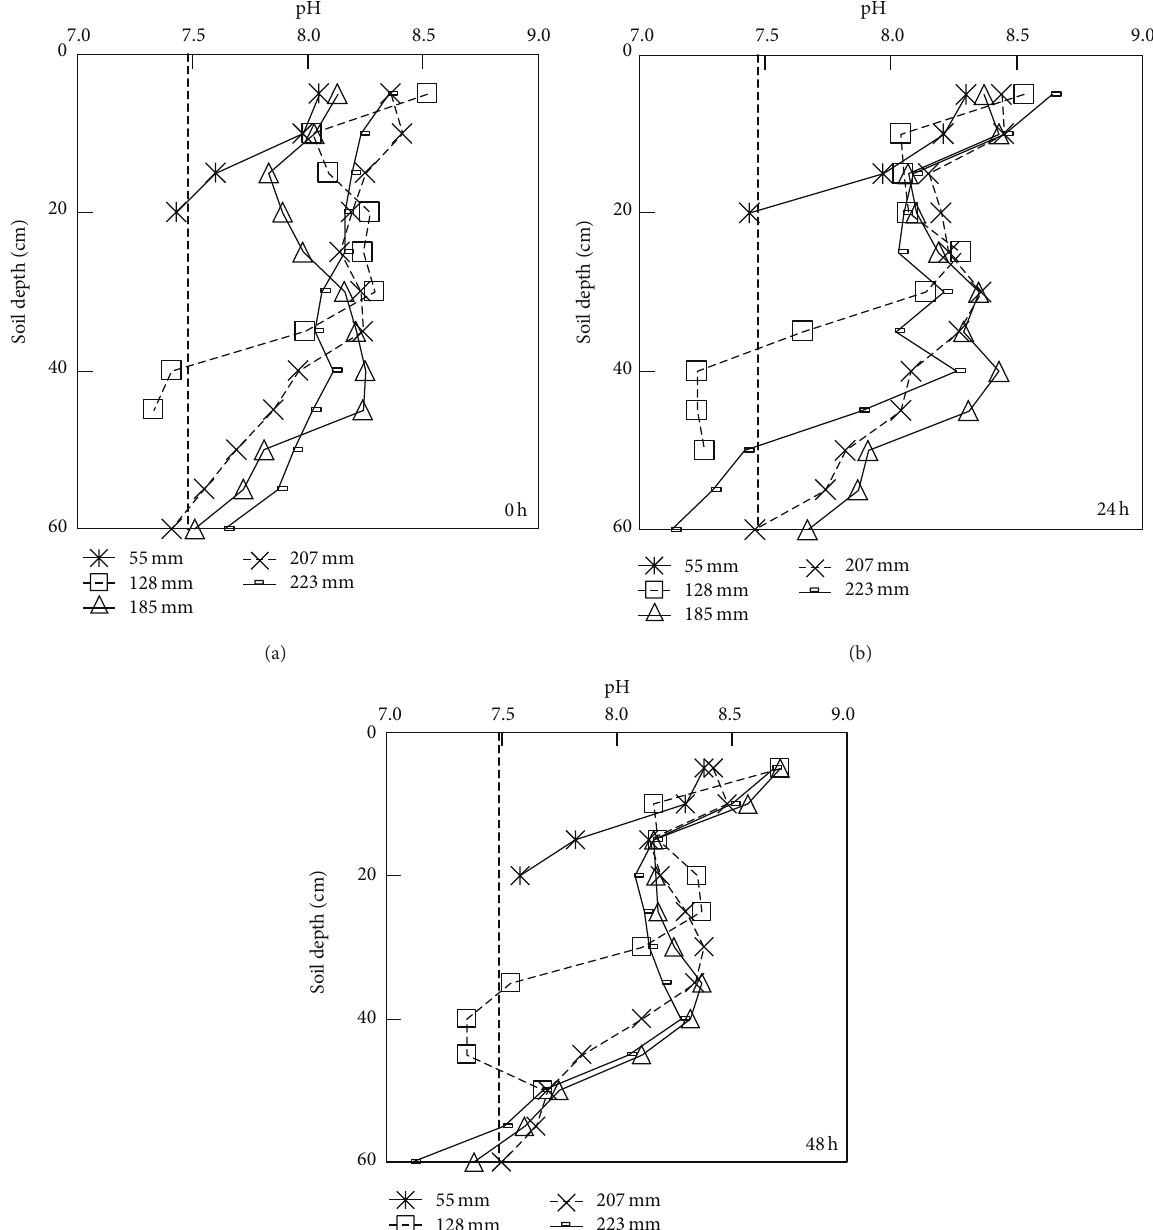
Figure 6: The depth distributions of pH at 0 hour (a), 24 hour (b), and 48 hours (c) during water redistribution under different water amounts